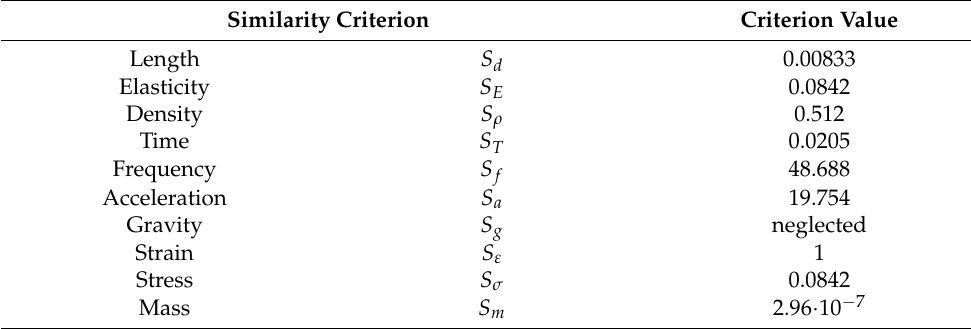
Table 4. Similarity criteria determined for the analyzed chimney.